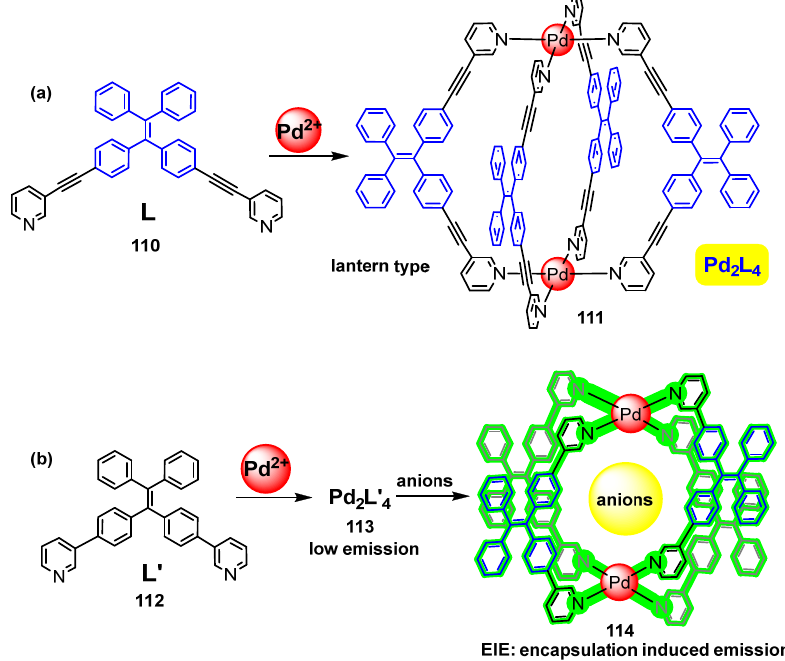
Figure 31. (a) Lantern-type complex Pd 2 L 4 111 built from ligand L 110 based on the TPE fragment. Adapted from [106]. (b) Lantern-type complexes Pd 2 L ʹ 4 113, 114 built from ligand L ′ 112 based on the TPE fragment: increase of the fl uorescence in 114 by EIE of anions. Adapted from [107].